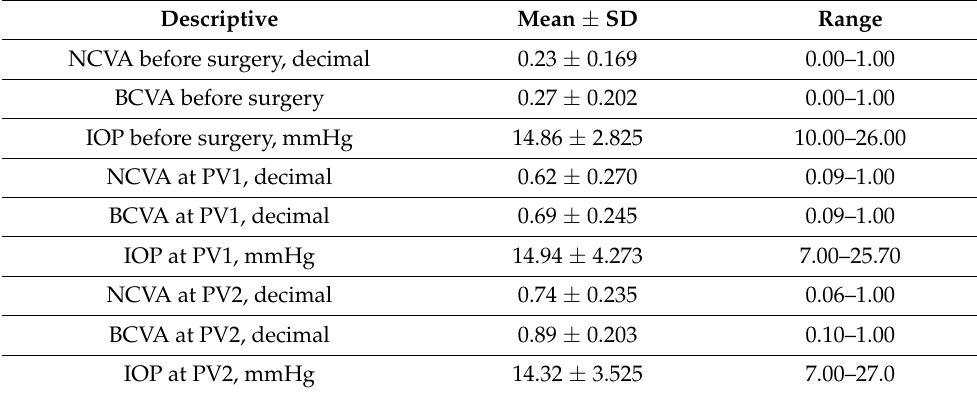
Table 2. Visual acuity and IOP data 1 .